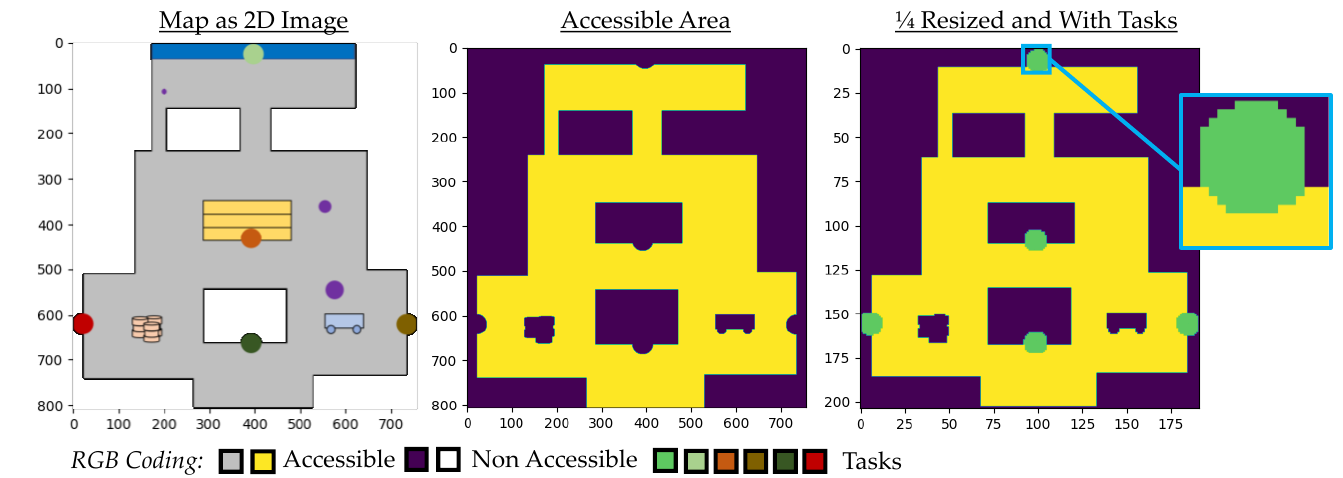
Figure 9. Segmentation in the foreground (yellow) and background (dark purple): RGB map, map with foreground and background, map with additional tasks (green).